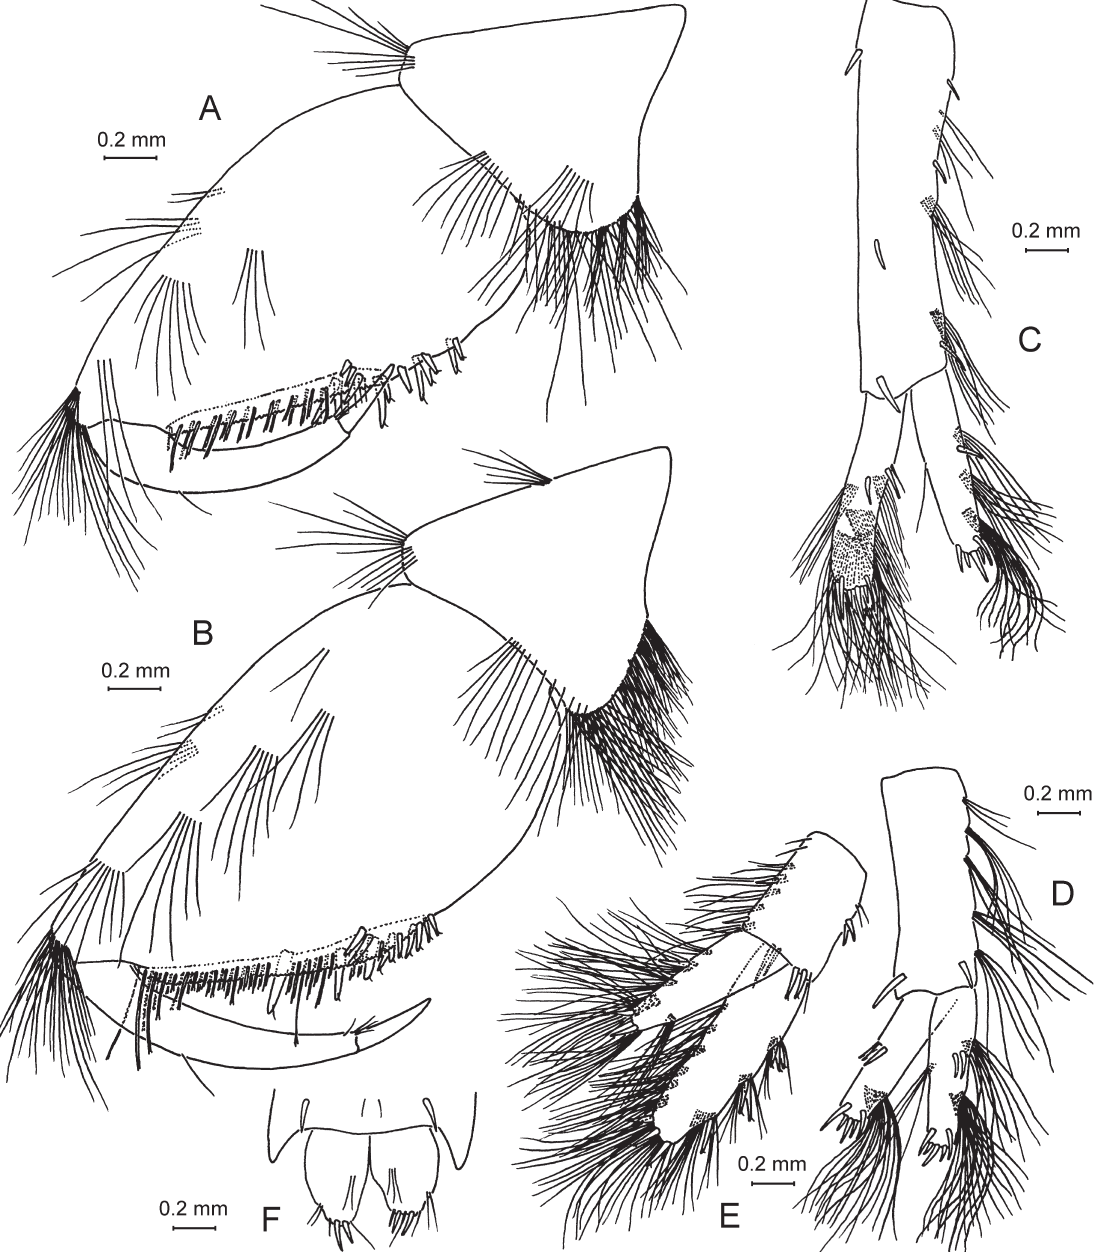
Fig. 16. Adaugammarus pilosus gen. et sp. nov. Paratype X44049/Cr-1655-FEFU, ♂, 17.5 mm. A . Gnathopod 1, part. B . Gnathopod 2, part. C . Uropod 1. D . Uropod 2. E . Uropod 3. F .